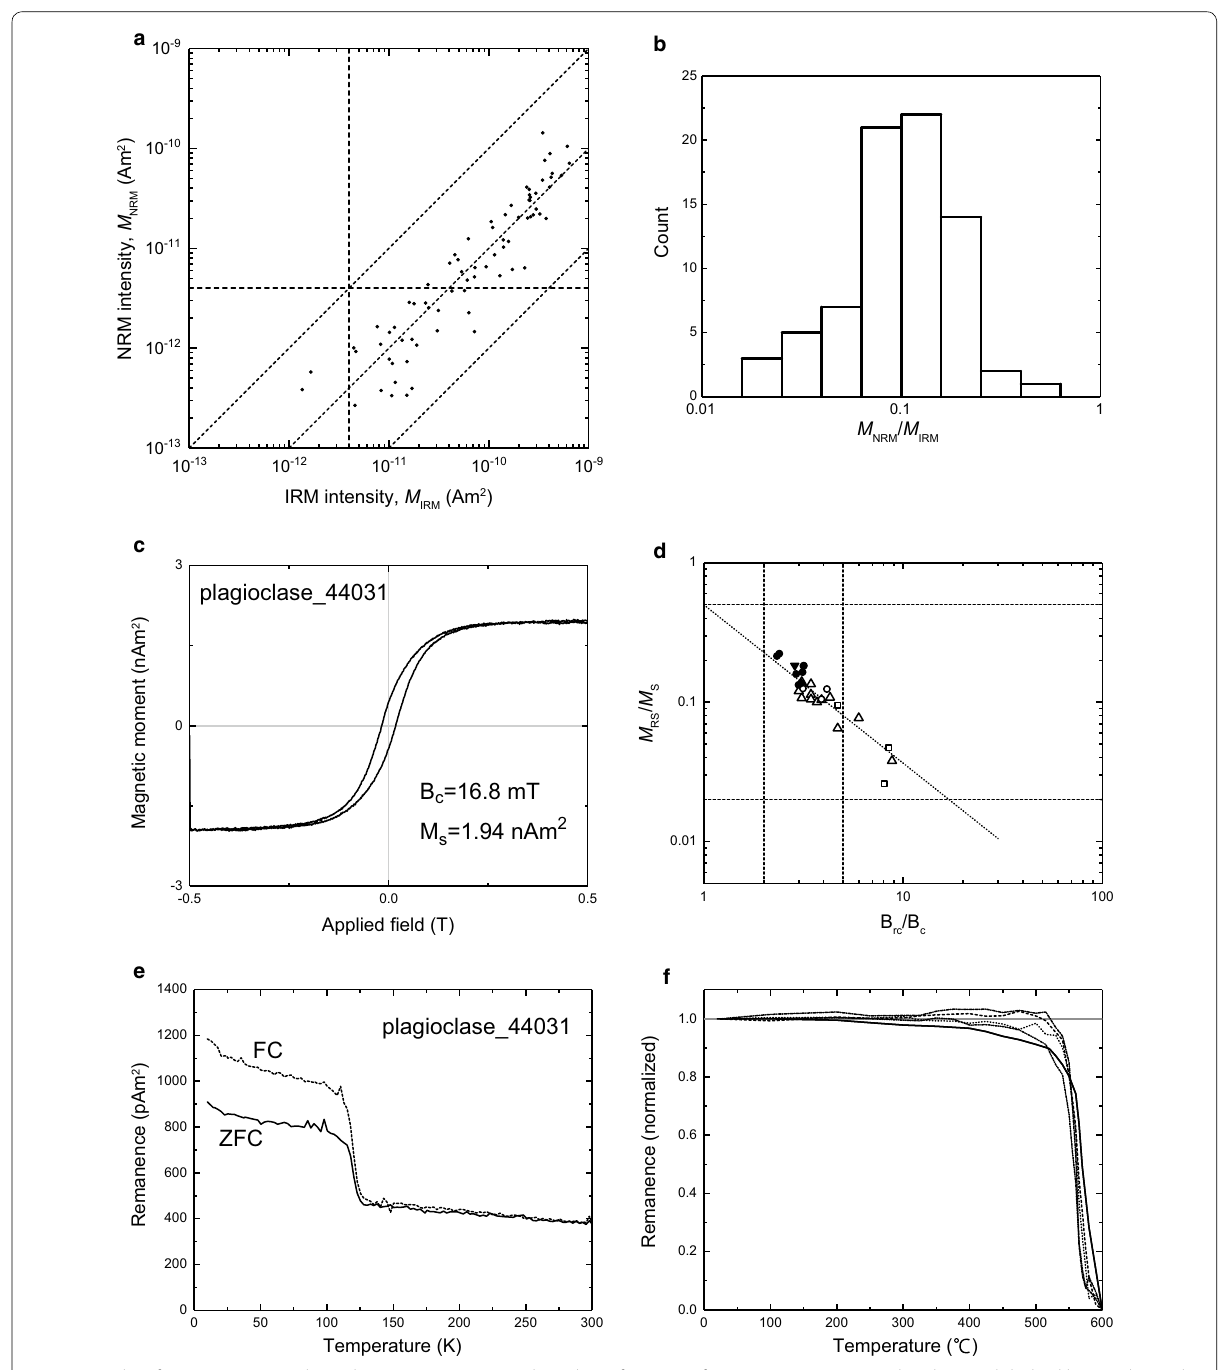
Fig. 6 Results of experiments on plagioclase. a NRM intensity plotted as a function of IRM intensity. Horizontal and vertical dashed lines indicate the threshold for significant remanence. b Histogram of NRM intensity divided by IRM intensity. c Representative hysteresis loop after slope correction. The slope correction coefficient was 61.4 nAm 2 /T. d Day plot of quartz and plagioclase grains shown with previous reports by Wakabayashi et al. + (2006). Closed symbols represent results of this study. Reversed triangle indicates quartz, and circle indicates plagioclase. Opened symbols represent results of Wakabayashi et al. (2006). Triangle, circle and square indicate non-separated chips, feldspar fraction and biotite fraction, respectively. Dotted lines show the SD-MD magnetite mixture trend after Channell and McCabe (1994) and Parry (1982). e Low-temperature remanence measurements. Solid lines for ZFC measurements and dotted lines for FC measurements. f Stepwise ThD of TRM given at 50 μT compared to that of TRM1 of the whole-rock sample ITG09b-34-1 (Wakabayashi et al. 2006). Dashed lines for plagioclase grains and solid line for whole rock. Solid gray line indicates TRM value before